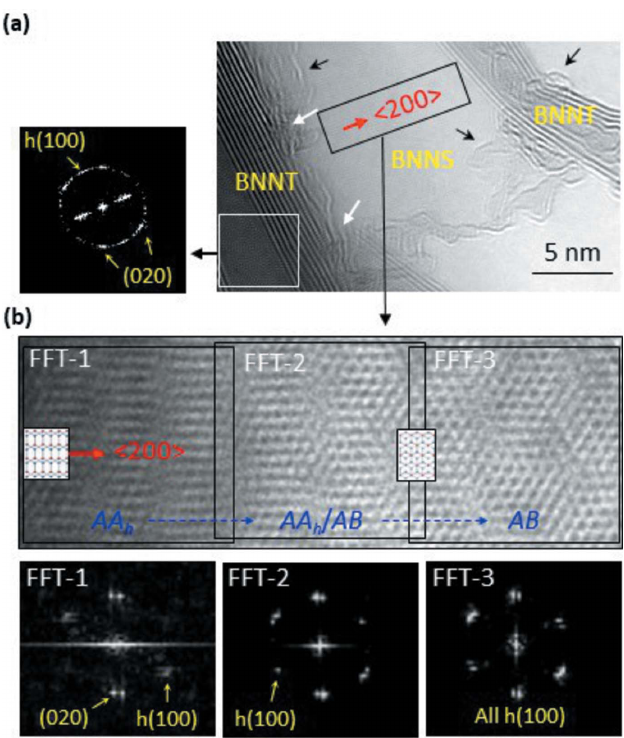
Figure 2 HRTEM data of a BNNT sample. ( a ) An HRTEM image of the BNNT sample, revealing the BNNT–BNNS structure where the BNNS grew from the BNNT on the left. ( b ) An atomic resolution image of the rectangle in ( a ). Split spots in the FFT patterns indicate that the BNNS consists of two BNNSs twisted by a few degrees. h (100) spots are of the hexagonal structure due to local sliding of the BN sheets destroying the orthorhombic